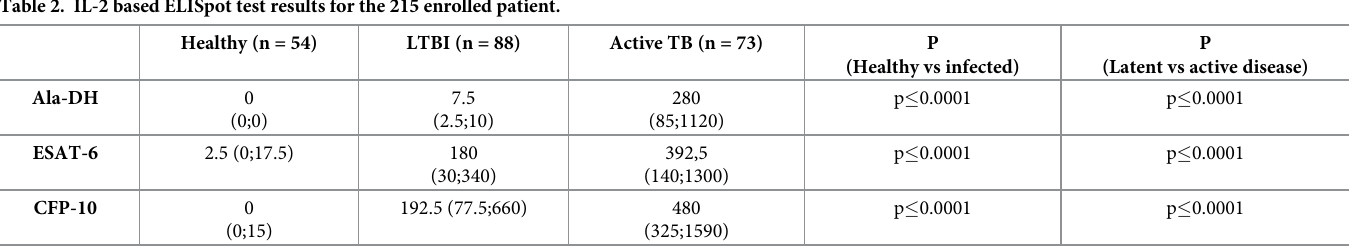
Table 2. IL-2 based ELISpot test results for the 215 enrolled patient.